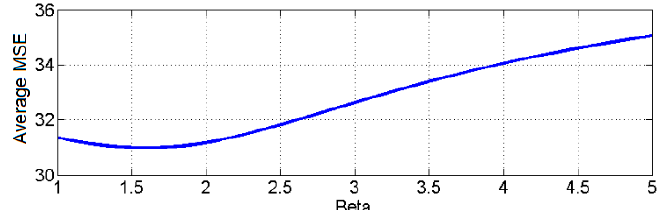
Figure 6. Average MSE computed as the average of the MSEs corresponding to all the series in a grid search with a step of 10 − 4 on the study interval.